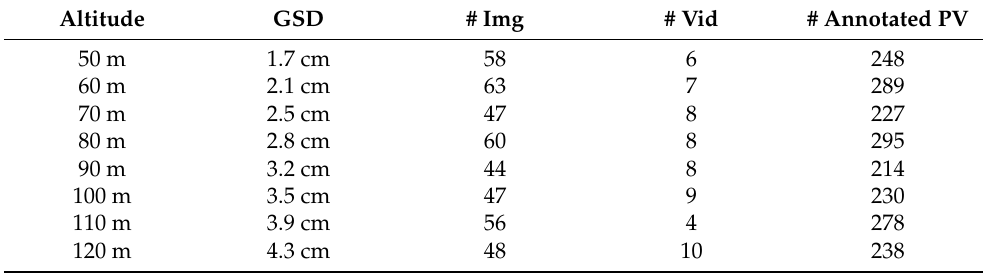
Table 1. Details of the dataset collected. Altitude and corresponding GSD are listed. Img: Images. Vid: Videos. In total there are 423 images, 60 videos, and 2019 annotated solar panels.